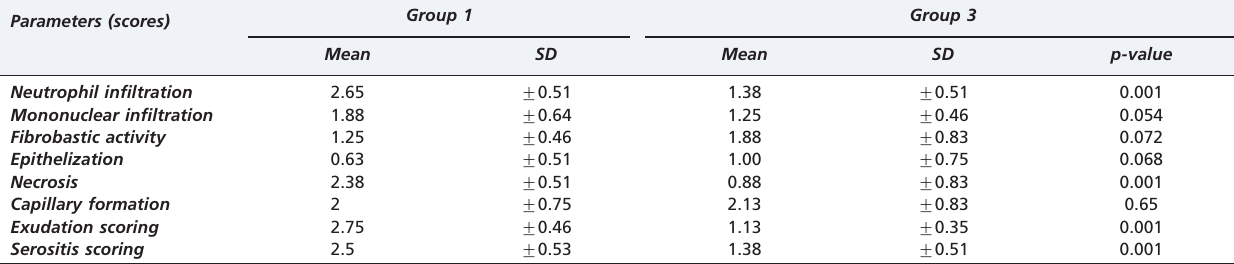
Table 3 - Histopathological differences between groups 1 and 3, sacrificed on postoperative day 3. Parameters